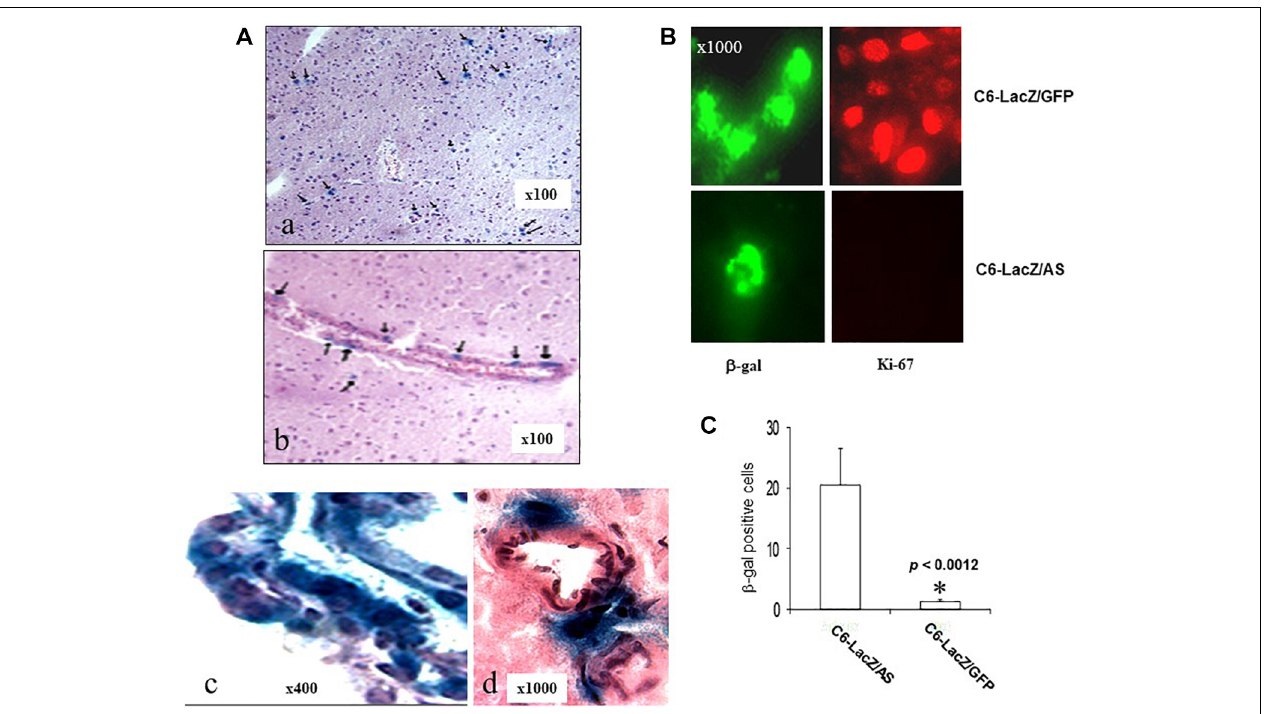
FIGURE 4 | Long-term survival of solitary, intra-cerebral tumor cells in C6/LacZ AS -injected rats. Brain sections (10 µ m) of rats that survived 182 days following C6-LacZ AS implantation (A) were immunostained to detect β -galactosidase activity. Shown are solitary cells identified in the brain parenchyma (a) , adjacent to ventricles (b) , within the choroid plexus (c) and in the perivascular space associated with small arterial vessels (d) . Immunohistochemistry (B) was performed on sections derived from the indicated surviving rats using antibodies to Ki-67 (right) or β -galactosidase (left). LacZ positive cells in the sections were quantified (C) in five random fields ( × 100 magnification) per section and three sections were analyzed per brain. Shown are mean numbers of β -gal + cells ( ± SD) in a total of 10–15 sections analyzed per group. ∗ p < 0.0012.